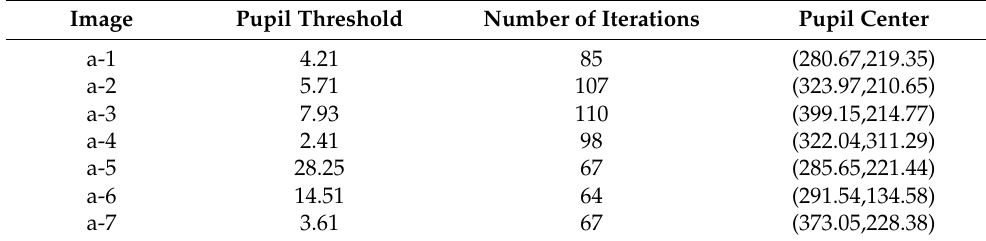
Table 5. Pupil segmentation detection results.